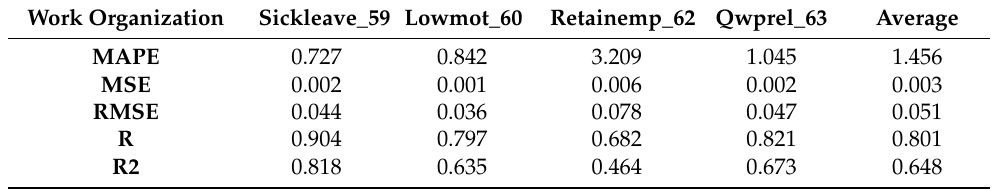
Table 7. Testing results for the effect of work organization on employee wellbeing.